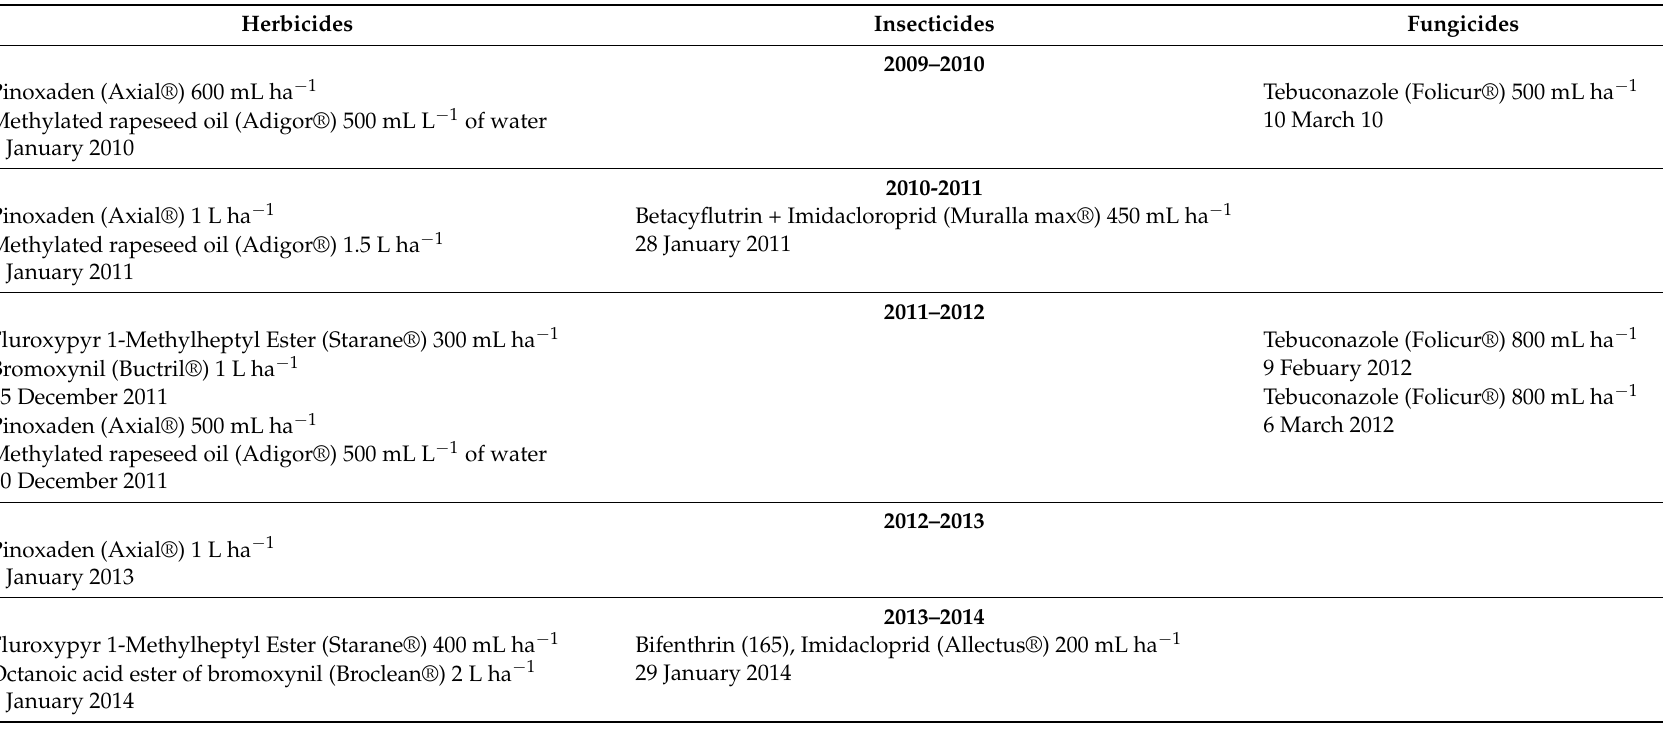
Table 1. Active ingredients, commercial names, rates and dates of application of herbicides and pesticides in experiments conducted at the International Maize and Wheat Improvement Center (CIMMYT), in the Yaqui valley, near Ciudad Obregon, Sonora,